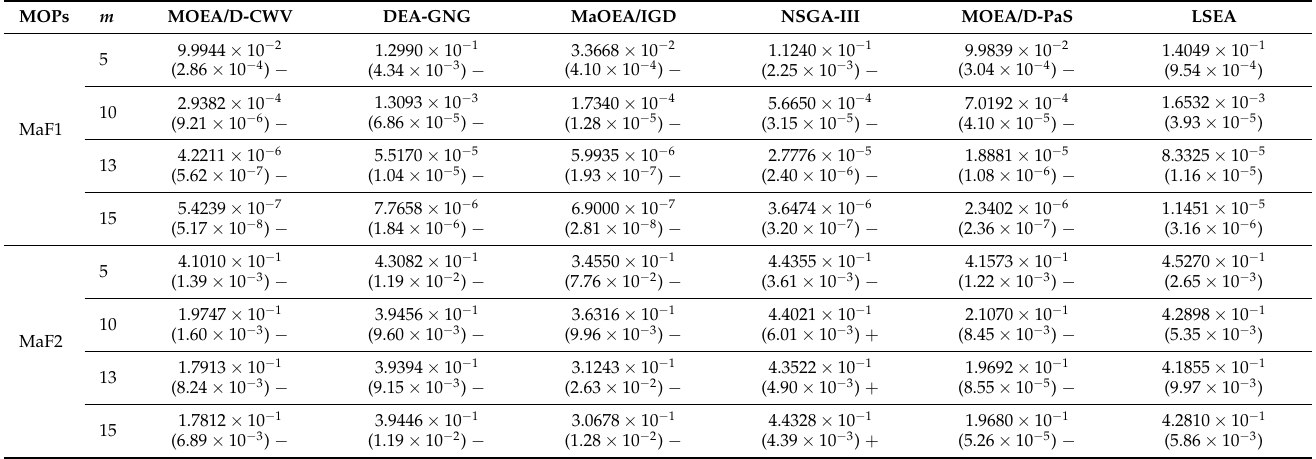
Table 1. HV values (average and standard deviation) obtained by the LSEA and the five baselines on MaF1–MaF9 with 5, 10, 13, and 15 objectives. Highest average HV value on each test instance is highlighted with a gray